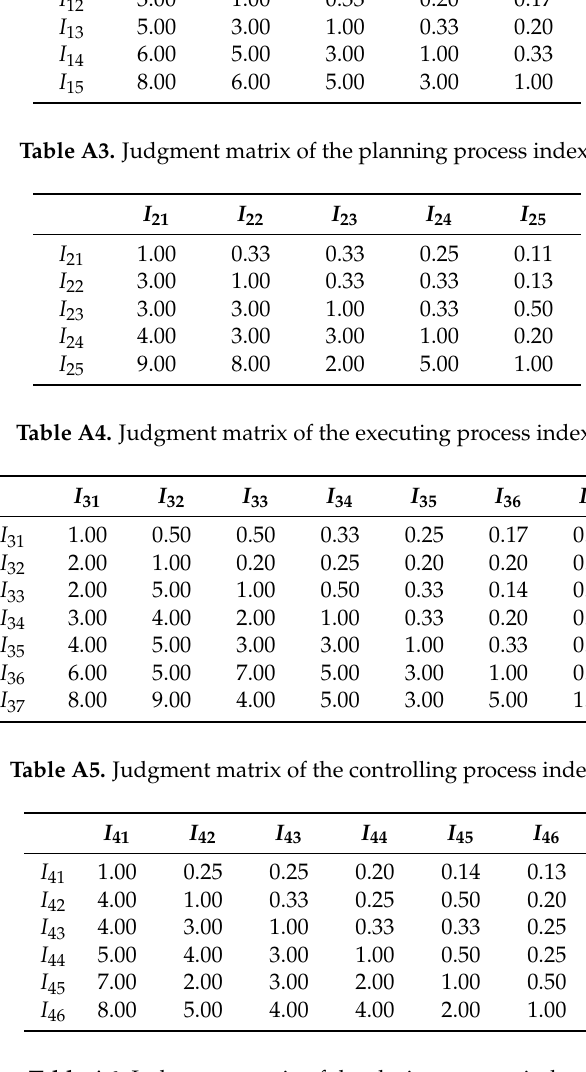
Table A6. Judgment matrix of the closing process